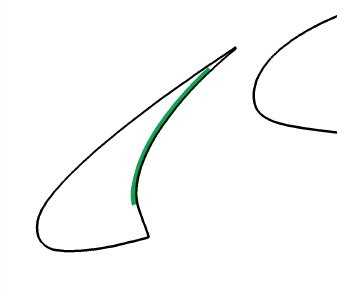
Figure 10. Position of the porous slat cove liner (green area) at F16 (reference airfoil) considered in the simulations with PIANO.